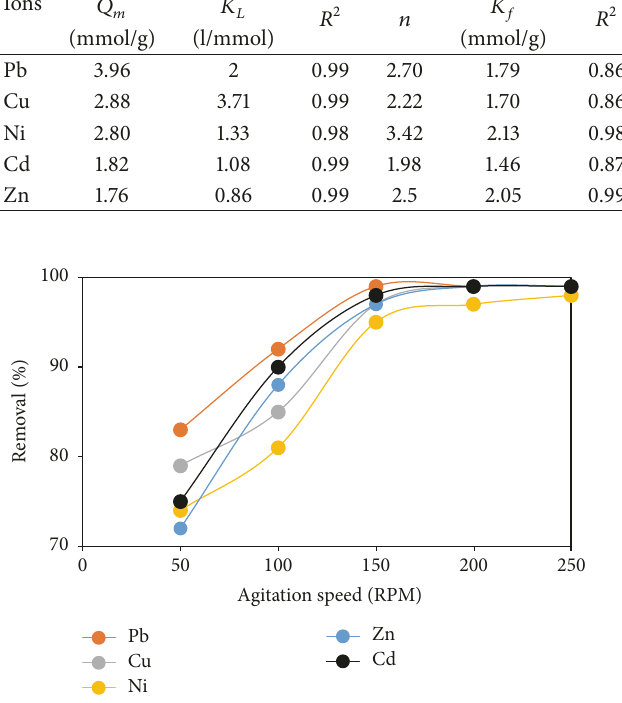
Figure 12: Effect of agitation speed on percentage removal of heavy metal ions by FGCX (conditions: 6 g/l FGCX; pH: Pb = 5, Cu = 5, Ni = 7, Zn = 6, and Cd = 6; contact time: 60min; initial concentration 0.5 mmol/L; temperature: 45 ∘ C).